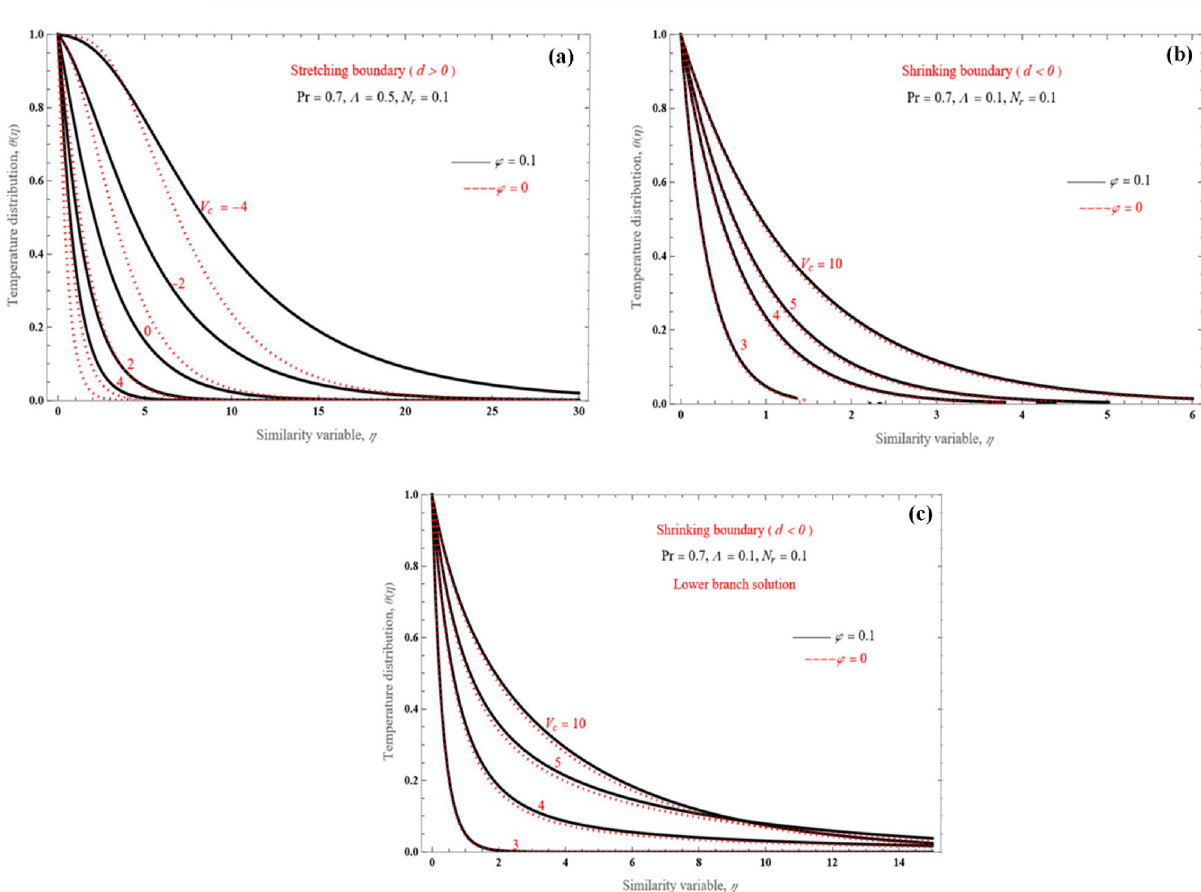
Figure 10. The effect of V c on temperature profile for ( a ) upper branch solution and d > 0 , ( b ) upper branch solution and d < 0 , ( c ) lower branch solution and d < 0